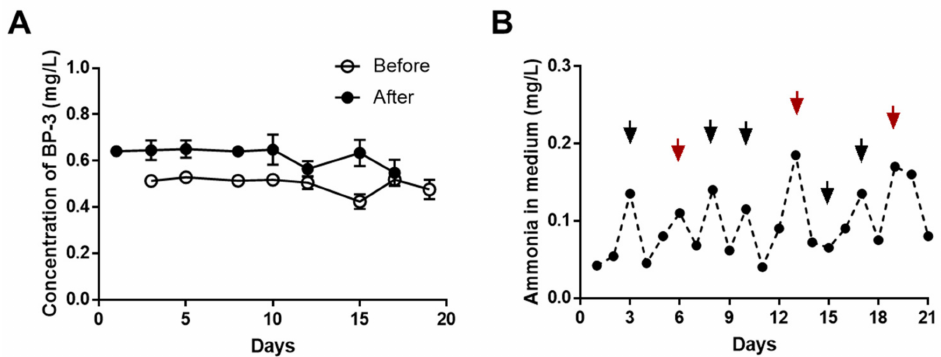
Figure 2. Concentrations of benzophenone-3 (BP-3) ( A ) and ammonia ( B ) during chronic toxicity test (21 days). ( A ) BP-3 was measured three times a week whenever the medium was changed. The concentrations of BP-3 were measured as 0.57–0.65 mg/L after replacing the culture medium (black circle) and as 0.43–0.53 mg/L before replacement (outlined circle). ( B ) Ammonia was measured daily. Black arrows indicate when half of the culture medium was exchanged, and red arrows indicate when the entire culture medium was